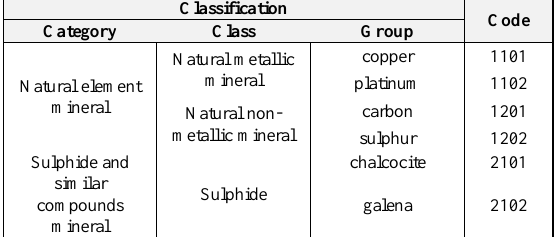
Table 3. The example mineral classification and coding scheme